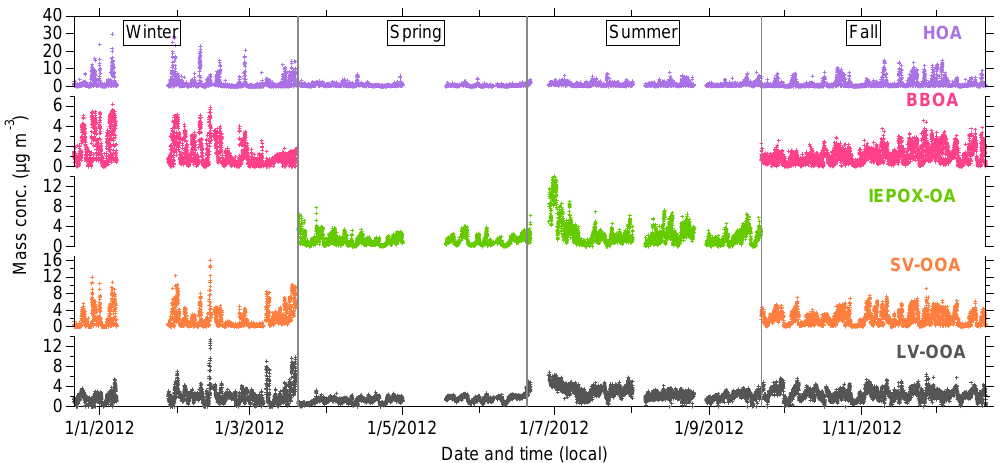
Figure 5. Annual temporal variation of PMF factors resolved from OA measured at JST in 2012.